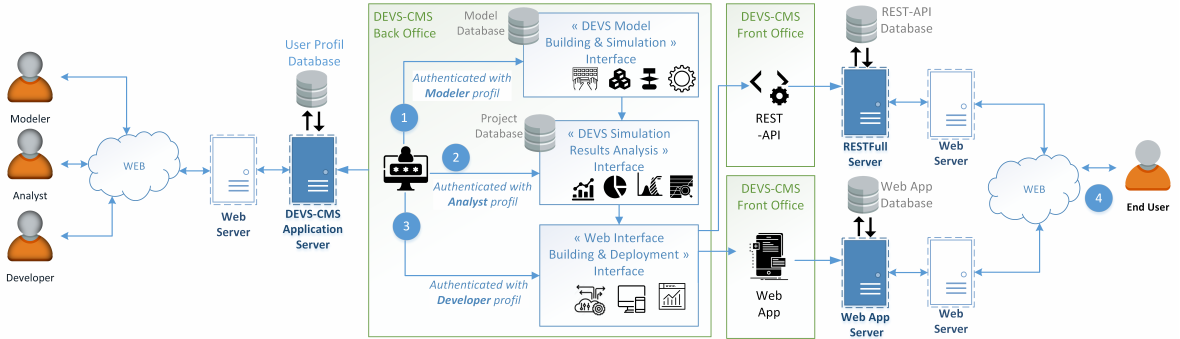
Figure 2. Architecture of the DEVS simulation model’s web interface manager, DEVS-MMS. Users (modelers, analysts, and web application developers on the left of the figure) access their respective back office after authentication (marked plain circles 1, 2, and 3) from the profile database. The modeler accesses the interface to build models and simulations that are necessary for the analyst, who produces the data visualization. These analysis elements are used to build web interfaces (REST API or web apps stored in the database), allowing the end-user to interact with simulation models remotely via the web (marked plain circle